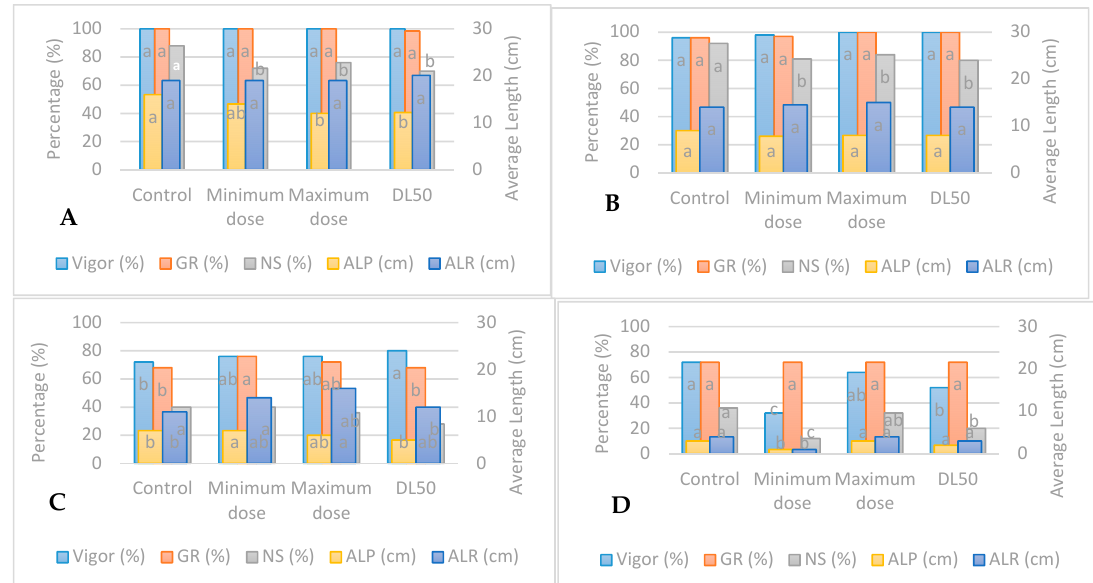
Figure 3. Standard germination tests performed on seeds of four species irradiated with UV-C at different concentrations: A . Glycine Max , B . Triticum aestivum , C . Helianthus annuus , D . Pinus maximartinezii ; GR = germination rate (%), NS = normal seedlings, ALP = average length of plumule; ALR = average length of radicle. Different letters in columns with the same color indicate significant differences ( p < 0.05).